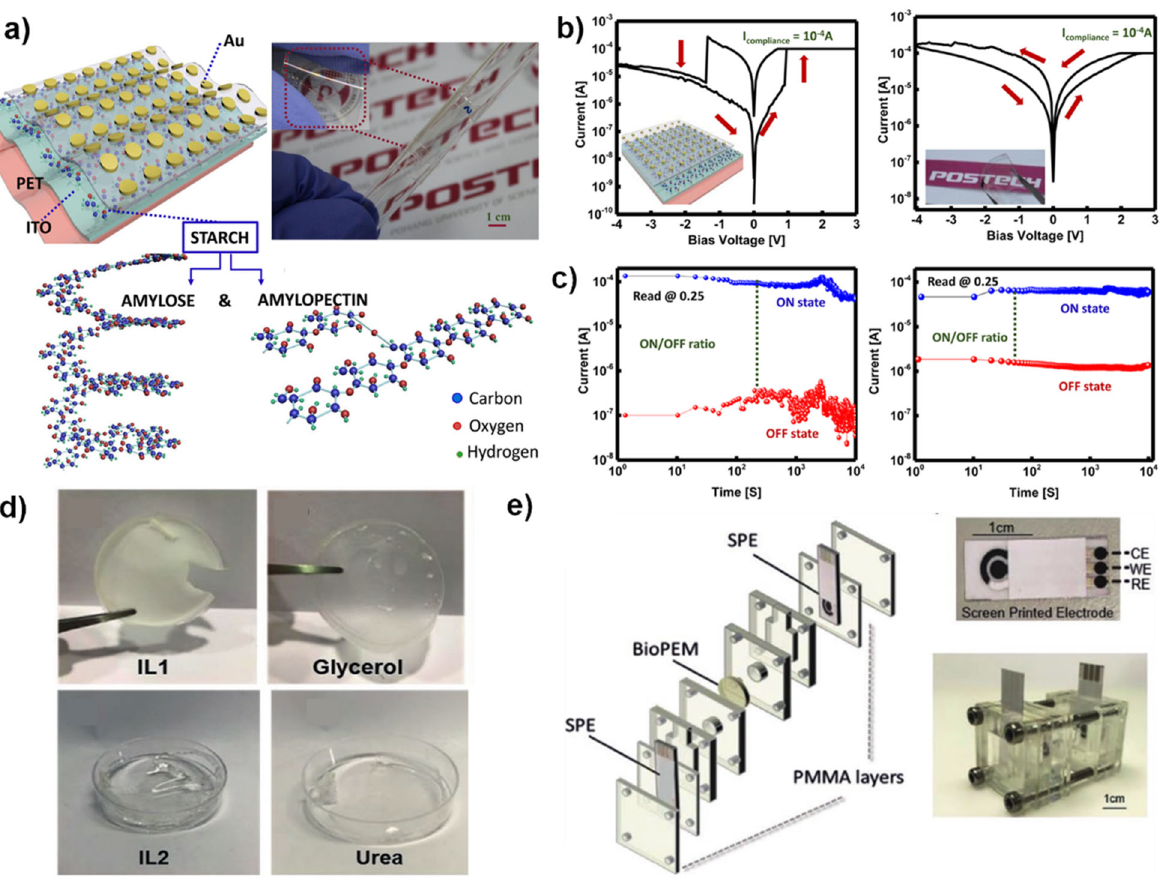
Fig. 7 Memory devices and batteries based on starch fi lms. a Schematic illustration of the structure and the photograph of fl exible ReRAM memory device on starch-chitosan. b I – V curves and c on/off ratio of the ReRAM devices composed of Au/starch/ITO/PET and Au/ starch − chitosan/ITO/PET. Reproduced with permission 35 . Copyright 2016, American Chemical Society. d Photographs of the starch based BioPEMs and e the corresponding battery cell. Reproduced with permission 135 . Copyright 2020,